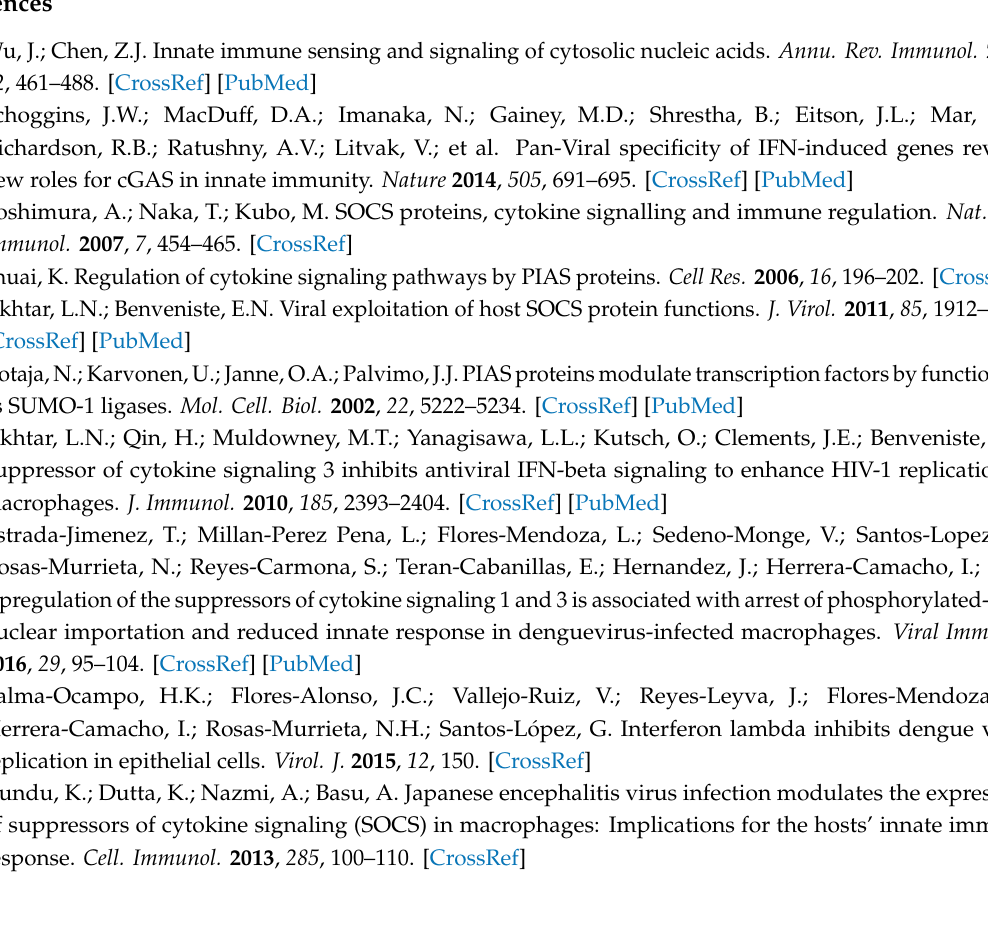
Figure S1: IFN- β activates phosphorylated